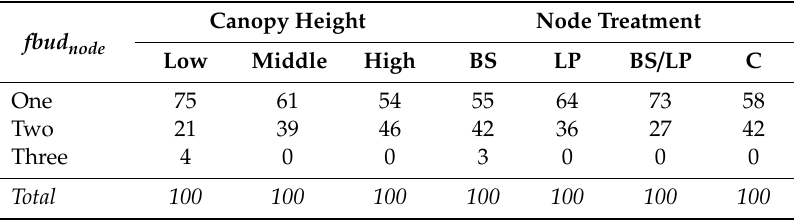
Table 2. The percentage of floral nodes with one, two, or three floral buds ( fbud node ) for each canopy height (low, middle, high) and for each node treatment (BS = bud shading; LP = leaf pluck; BS / LP = bud shading plus leaf pluck; C = control). Pearson’s chi-square test with canopy height, X 2 (4, N = 122) = 7.443, p = 0.114. Pearson’s chi-square test with node treatment, X 2 (6, N = 122) = 4.840, p = 0.564. Canopy Height Node Treatment fbud node Low Middle High